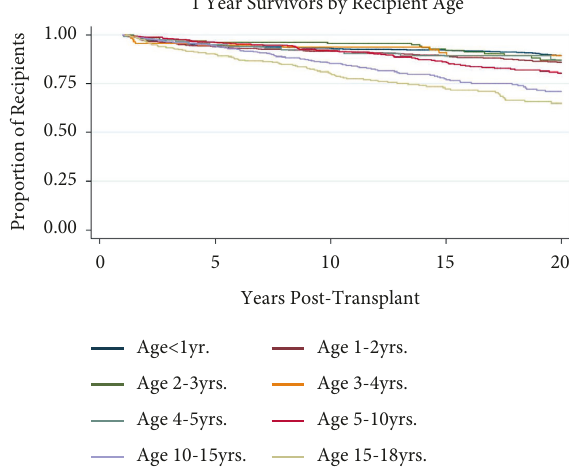
Figure 2: Kaplan–Meier survival function over time for 1-year survivor pediatric liver transplant recipients by